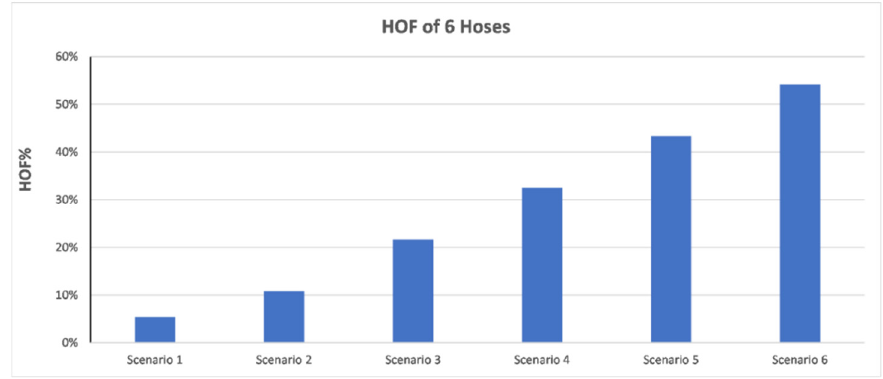
Figure 9. HOF indicator for 3 dispensers.